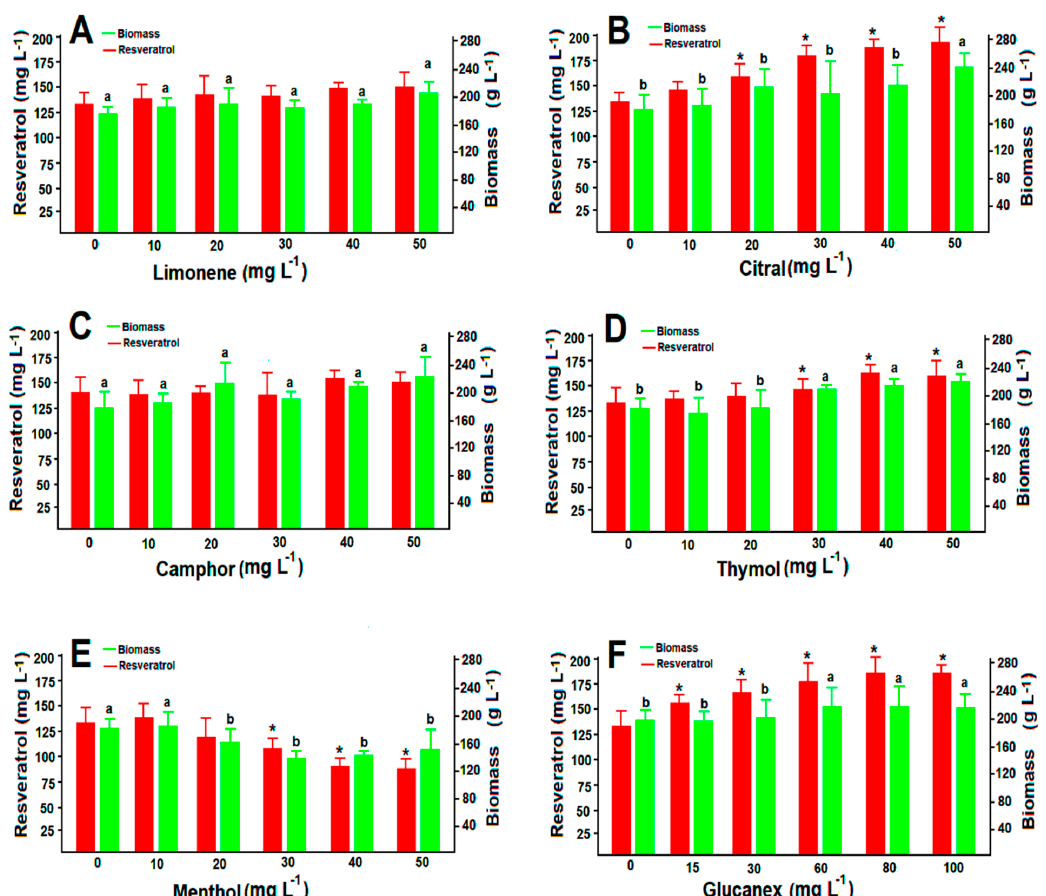
Figure 6. Production of RV and biomass by the addition of different concentrations (0–50 mg L − 1 ) of limonene ( A ), citral ( B ), camphor ( C ), thymol ( D ), menthol ( E ) and Glucanex ( F ) (0–100 mg L − 1 ) in batch cultures of A. aureus MaC7A analyzed at 7 days post-treatment. * Indicates statically significant differences ( p < 0.05) for RV production compared with the control group (0 mg L − 1 ). Means with different letters indicate statically significant differences among the biomass and volatile concentrations ( p < 0.05). Error bars represent SD (n = 10).